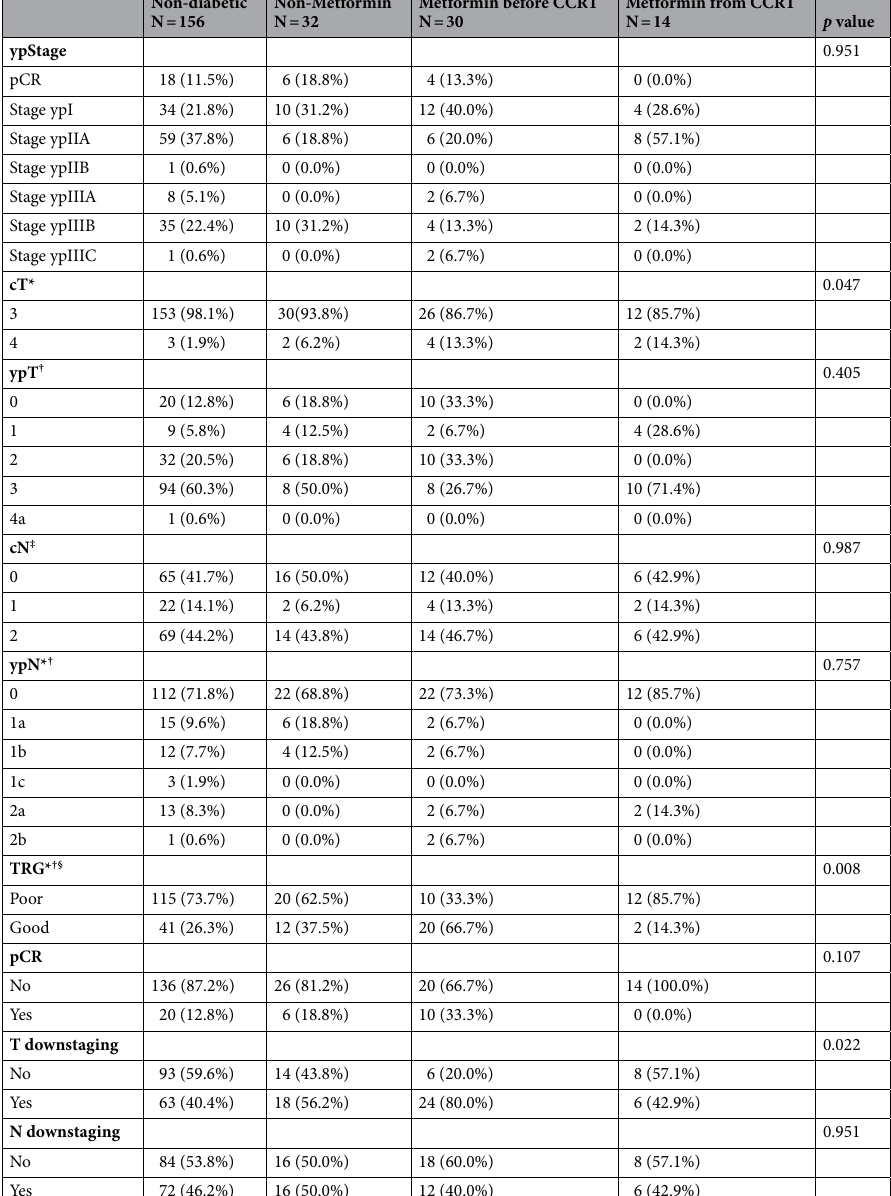
Table 2. Tumor response by groups. Data are n (%), TRG = tumor regression grade, pCR = pathologic complete response, cT* = Clinical Tumor stage; ypT† = Pathological tumor stage; cN‡ = Clinical Node